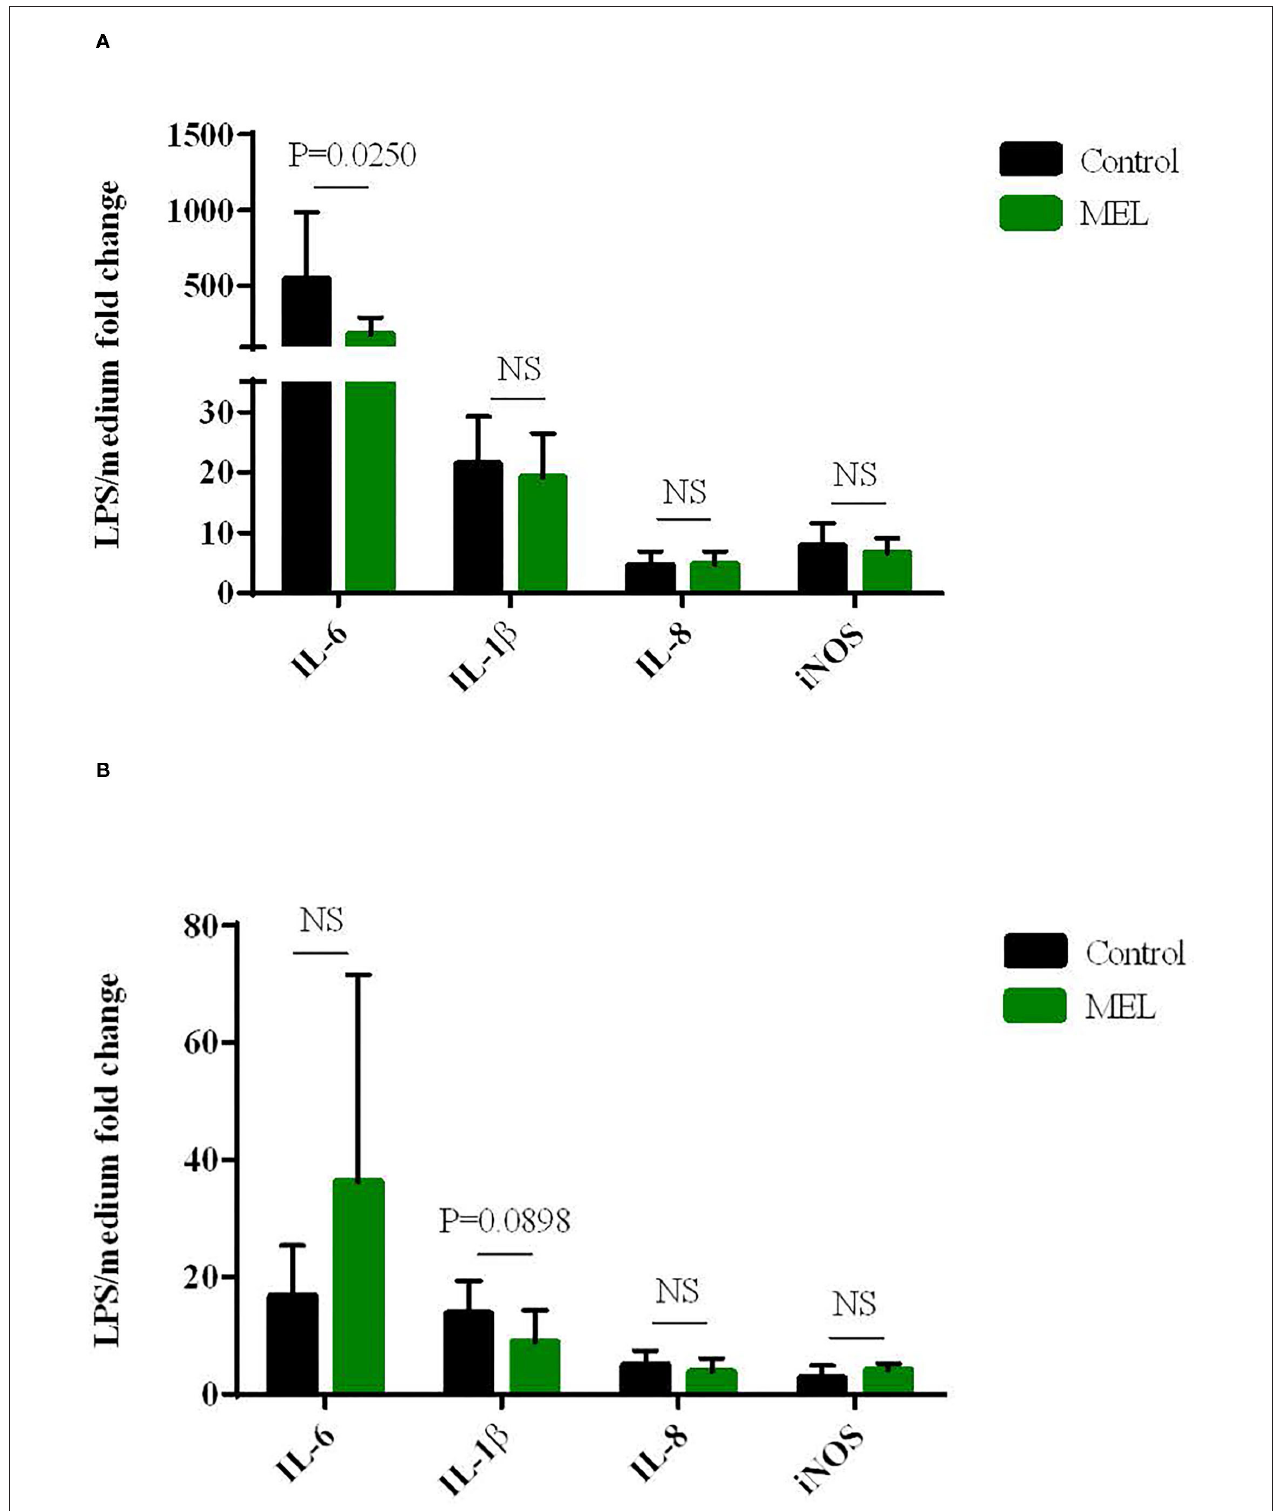
FIGURE 3 | Effects of MEL extract supplementation on the expression of cytokines and iNOS mRNAs in chicken blood cells maintened for 6 hours in culture ( ex vivo ) with LPS (10 µ g/mL) at D14 (A) and D30 (B) . mRNA expression was normalized to GAPDH, HPRT and RPS8 reference genes. Data represent mean ± SEM ( n = 12). Data were analyzed by ANOVA or with non-parametric Mann-Whitney test. NS = P > 0.01.